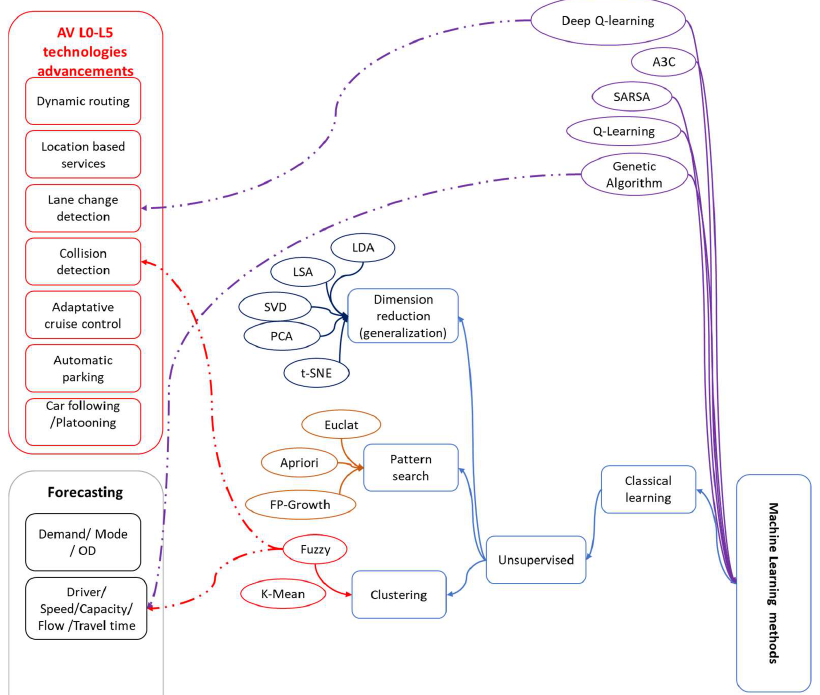
Figure 10. Graph of partial ML algorithms linked to application areas by papers.